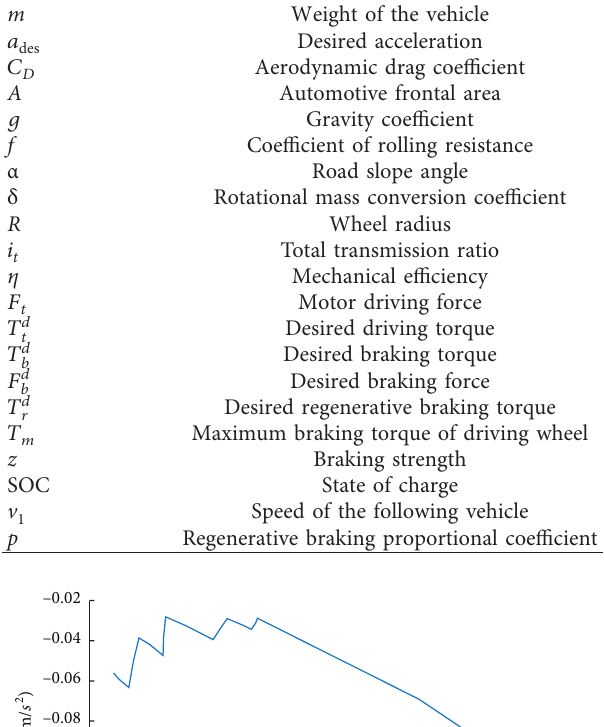
Figure 1: Schematic diagram of the forces exerted on the vehicle while driving. Table 1: Parameters in the vehicle longitudinal dynamics and braking strategy.